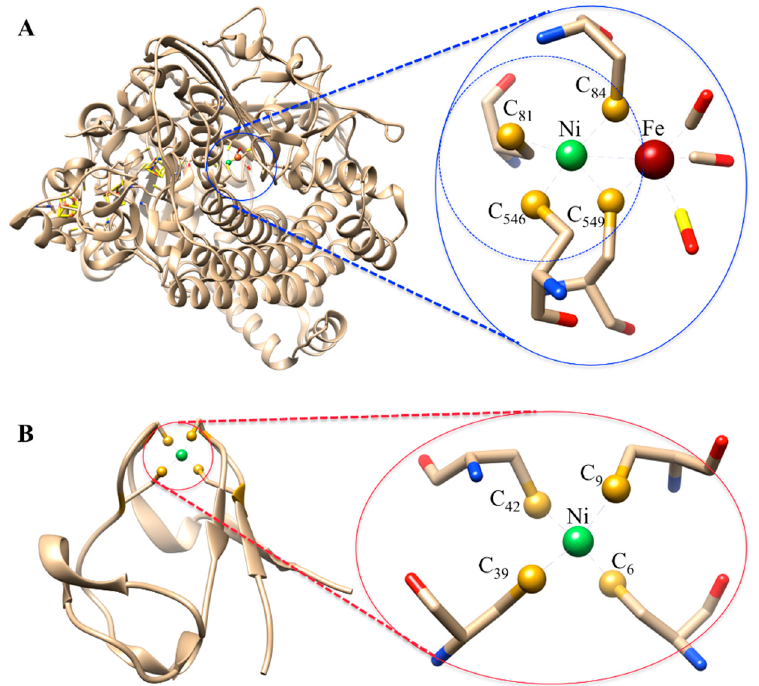
Figure 2. The Ni-Rd model shows identical structural features at the primary coordination sphere of Ni-fragment of native [Ni-Fe]-hydrogenase. ( A ) Crystal structures of [Ni-Fe]-Hydrogenase from Desulfovibrio vulgaris Miyazaki F (PDB:1H2R), highlighted the [Ni-Fe] active site with cysteine coordination and ( B ) Crystal structure of Ni-Rd from Desulfovibrio gigas (PDB:1R0J), highlighted the Ni-site with cysteine coordination.